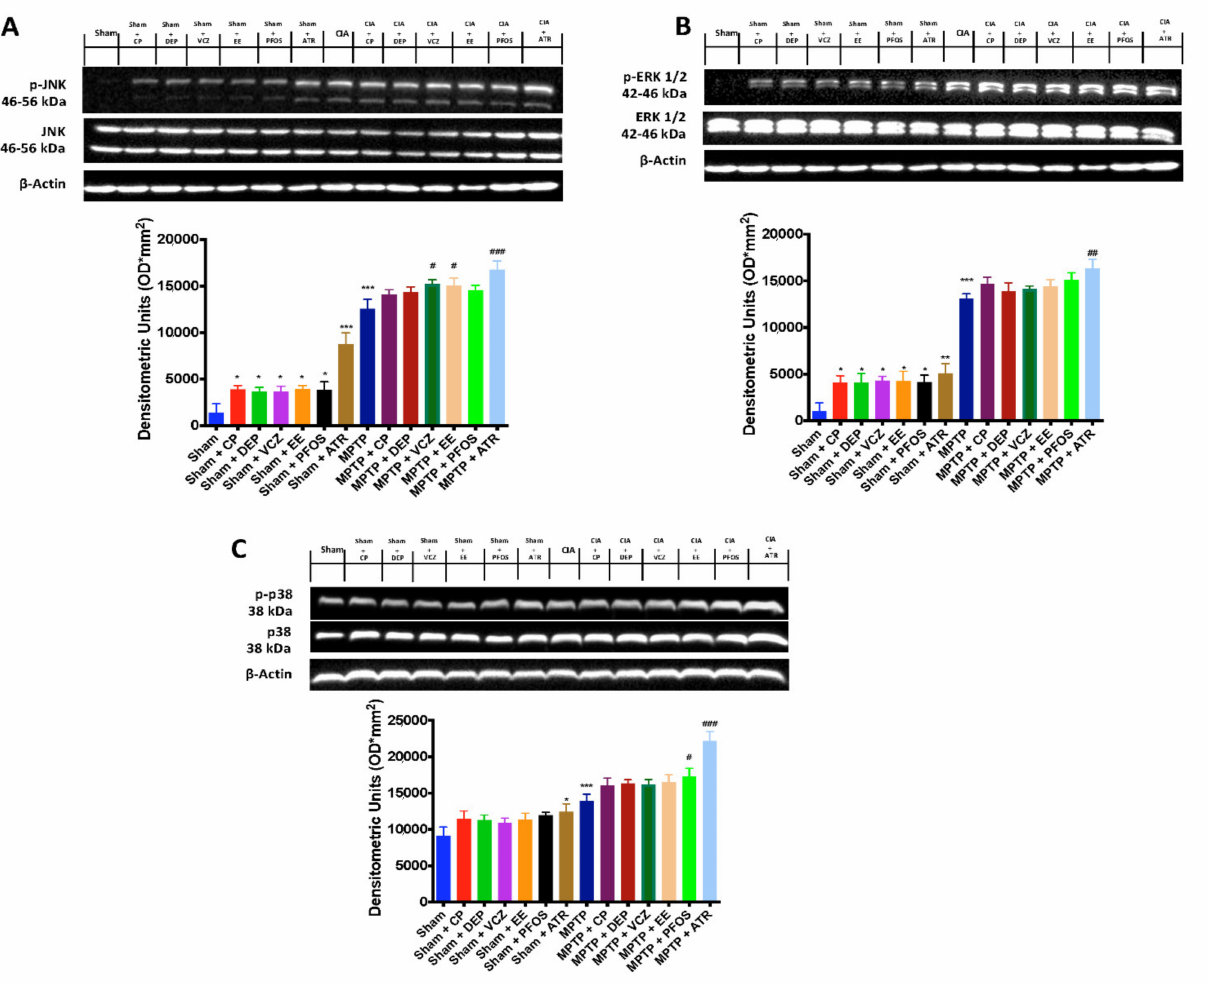
Figure 7. Western blots and densitometric analysis of p-JNK ( A ), p-ERK 1/2 ( B ) and p-p38 ( C ). A demonstrative blot of lysates with a densitometric analysis for all animals is shown. Data are ex- pressed as the mean ± SEM of N = 6 mice/group. * p < 0.05 vs. sham; ** p < 0.01 vs. sham; *** p < 0.001 vs. sham; # p < 0.05 vs. MPTP; ## p < 0.01 vs. MPTP; ### p < 0.001 vs.